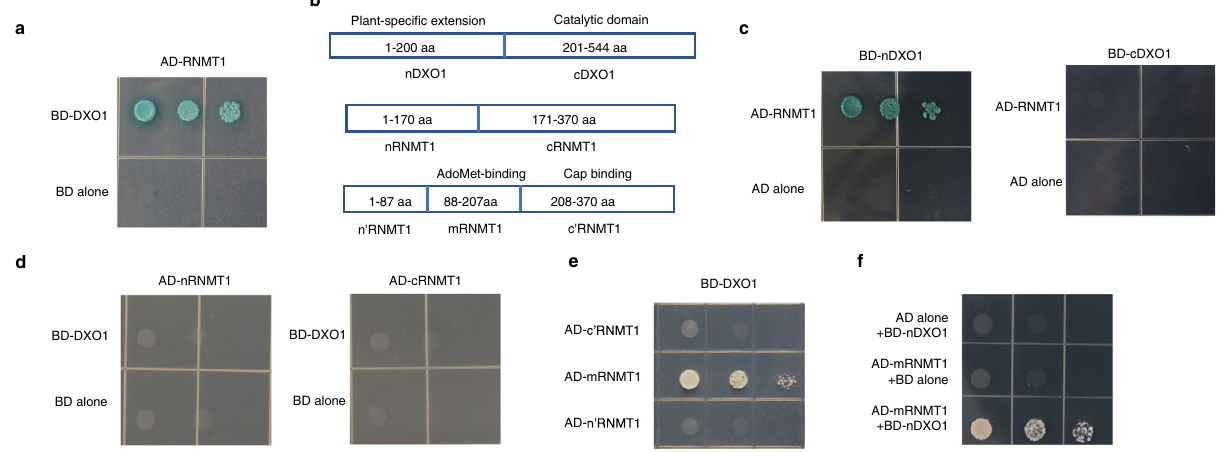
Fig. 1 |DXO1interactswith RNMT1intheyeast two-hybridsystem. a Yeast cells transformed by pGADT7-RNMT (AD-RNMT1) together with pGBKT7-DXO1 (BD- DXO1),butnotwiththeemptyvector pGBDT7 (BDalone),wereabletogrowonthe selective medium. b Schematic diagrams of different regions of DXO1 and RNMT1 testedfortheirinteractionbyY2Hassayandotherassaysinthisreport. c Theplant- speci fi c N-terminal extension of DXO1 (nDXO1) interacted with RNMT1. Yeast cells transformed by BD-RNMT1 together with BD-nDXO1 , but not with BD-cDXO1 , were abletogrowontheselectivemedium. d nRNMT1andcRNMT1didnotinteractwith